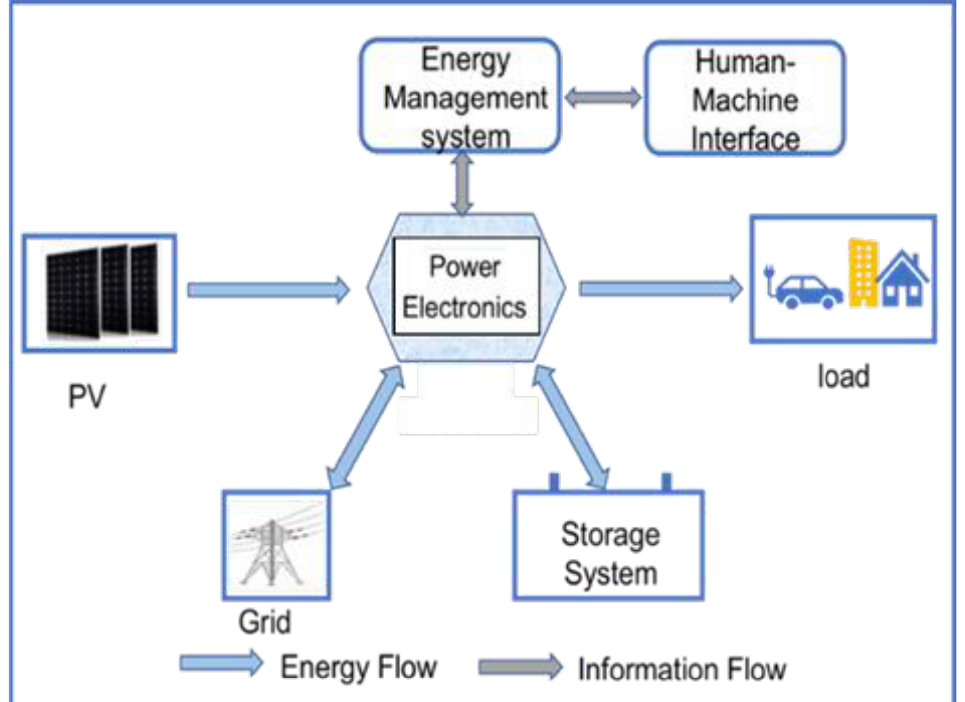
Figure 1. DC microgrid.